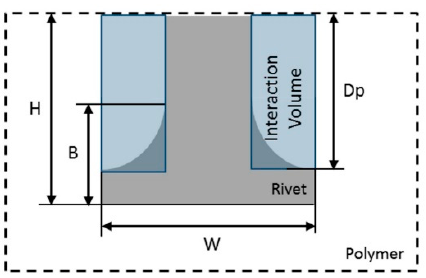
Figure 3. Schematic representation of joint formation geometrical measurements on a bell-shaped deformed rivet tip.